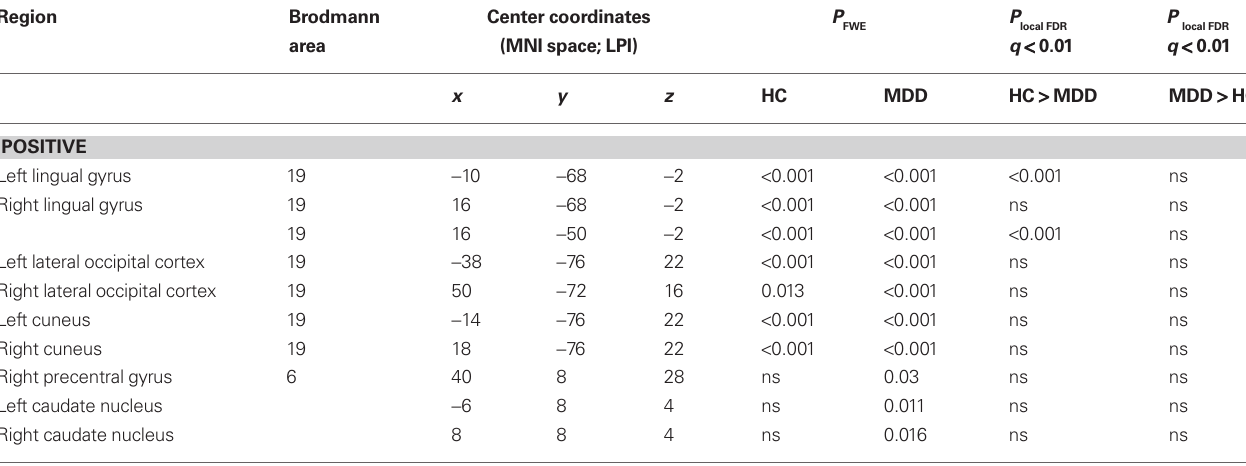
Table 4 | rSN 3 characteristics and